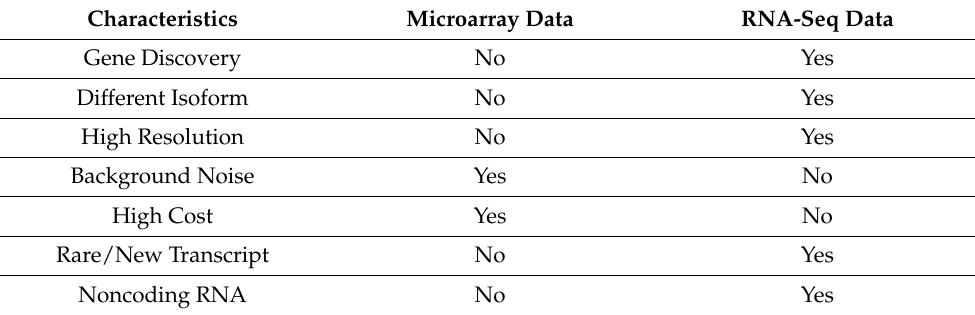
Table 2. Comparison between microarray and RNA-Seq data.